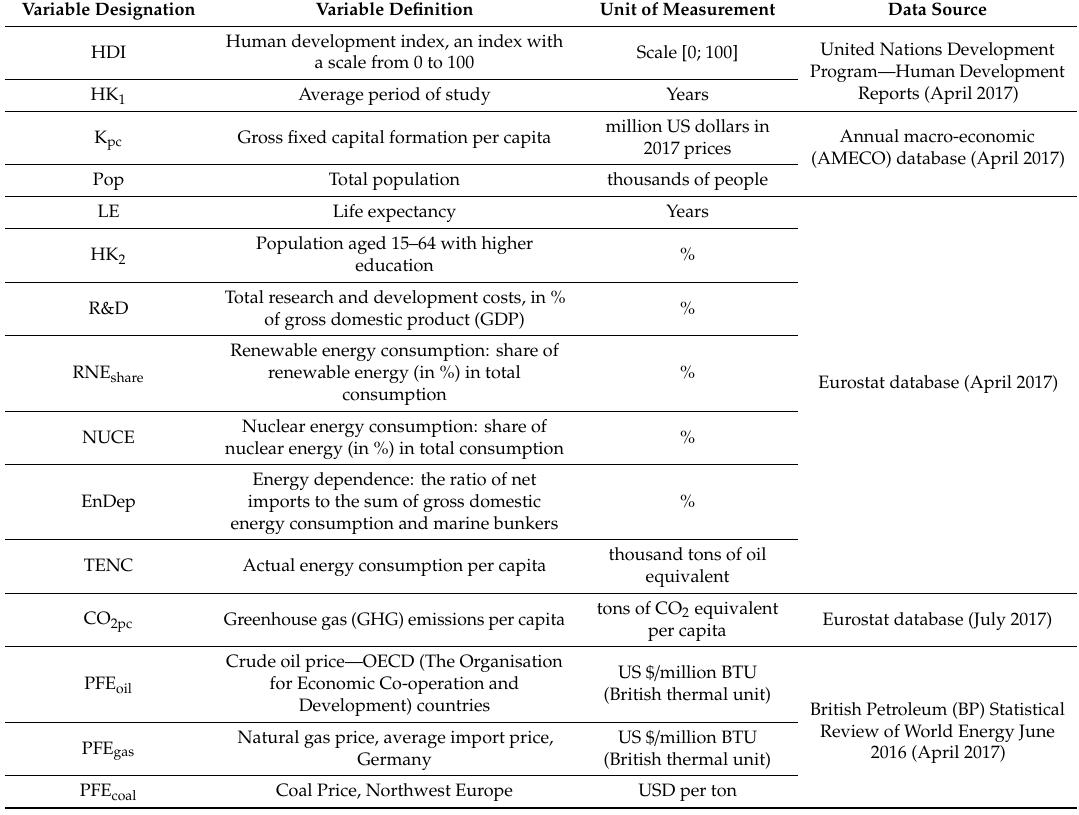
Table 1. Variables of the model of the relationship between energy consumption, HDI, and the level of sustainable development of